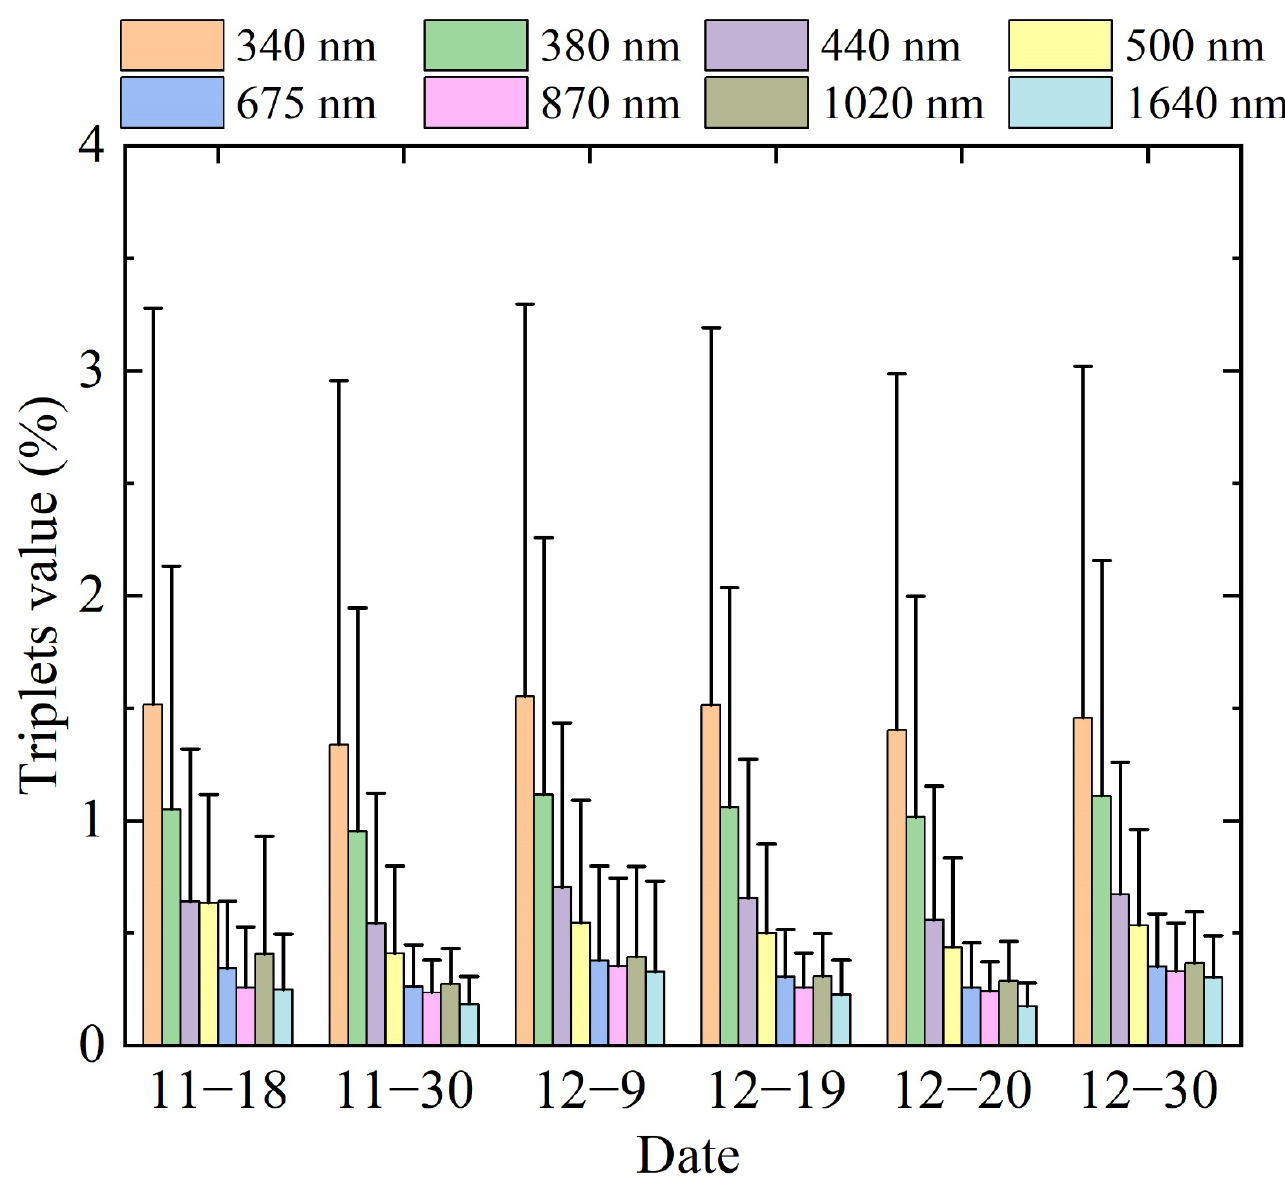
Figure 5. Daily variation of the average triplet ratio at each wavelength on the six study days.